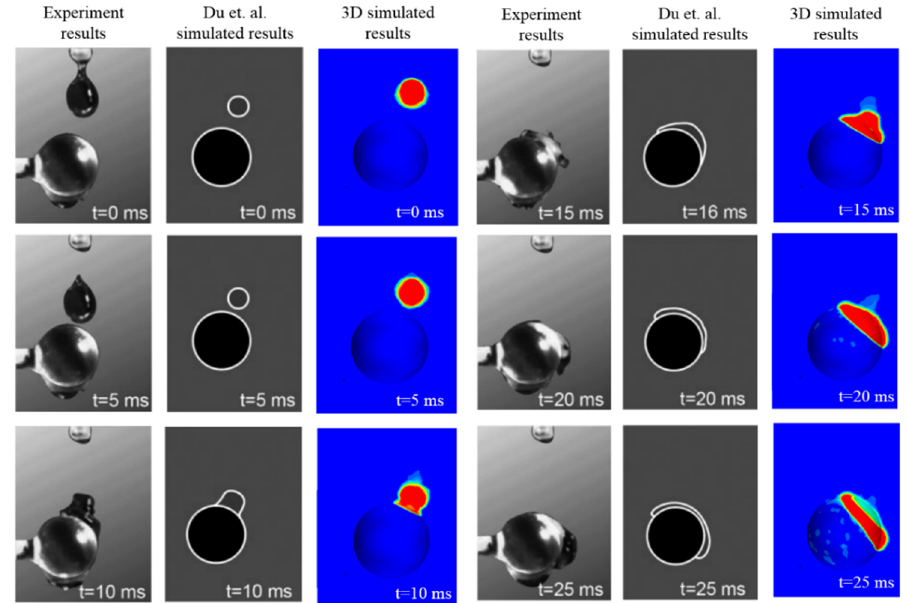
Figure 3. Comparisons of snapshots between experiment [19] and VOF simulations of a droplet falling.